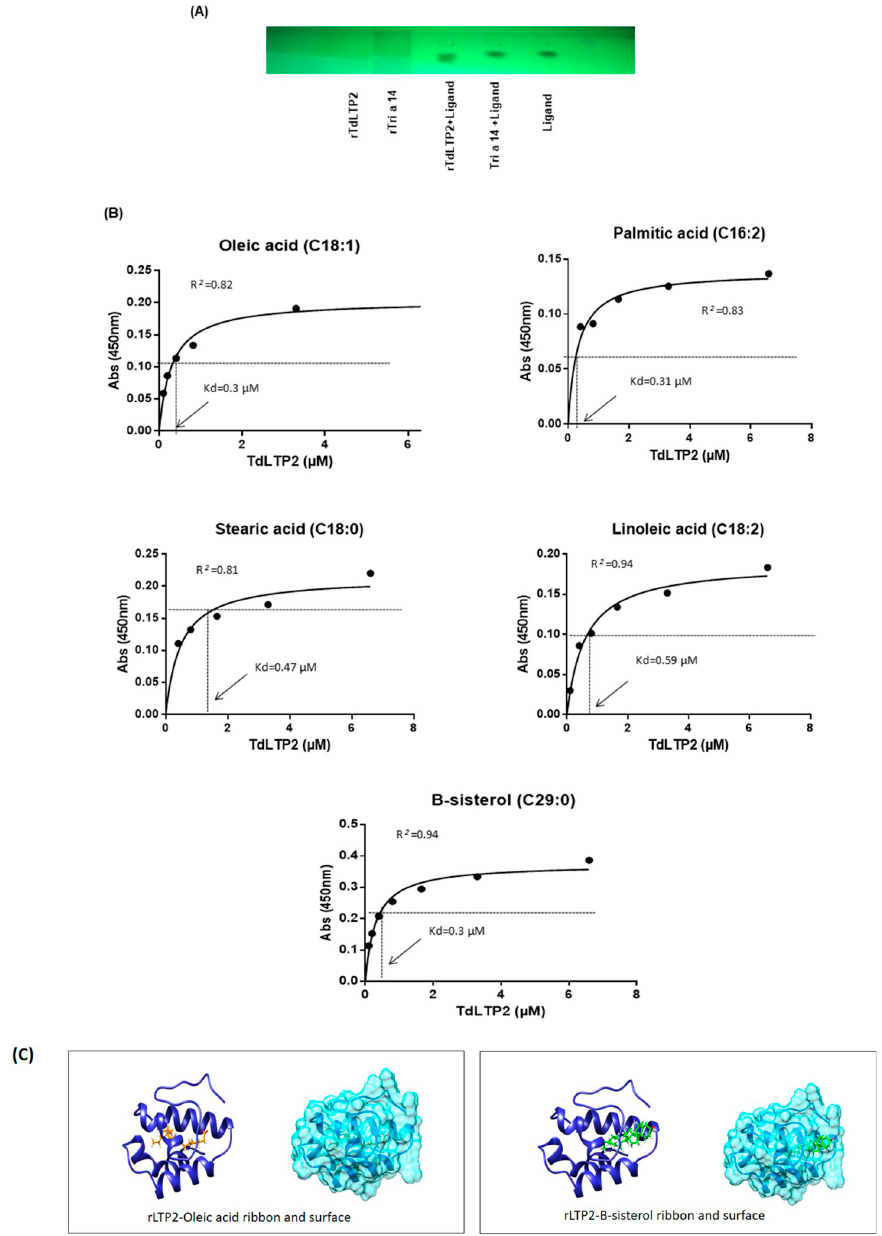
Fig 5. In vitro lipid binding activity of rLTP2 using different experiments. (A) Observation of the ligands by TLC in a silica gel plate and Emission of the bands under UV light (365 nm). (B) The binding ability of FAs with (50 μ g/ml) for each lipid was tested at varying concentrations (6.6, 3.3, 1.6, 0.8, 0.4, 0.2 and 0.1 μ M). Hydrophobic ELISA plates were coated with the indicated lipids. Protein binding was revealed using polyclonal antibody against rTdLTP2. Graphs illustrate the means of the absorbance values at 450 nm ± SEM, n = 3. (C) Molecular dynamics of oleic acid and sitosterol entering the cavity of